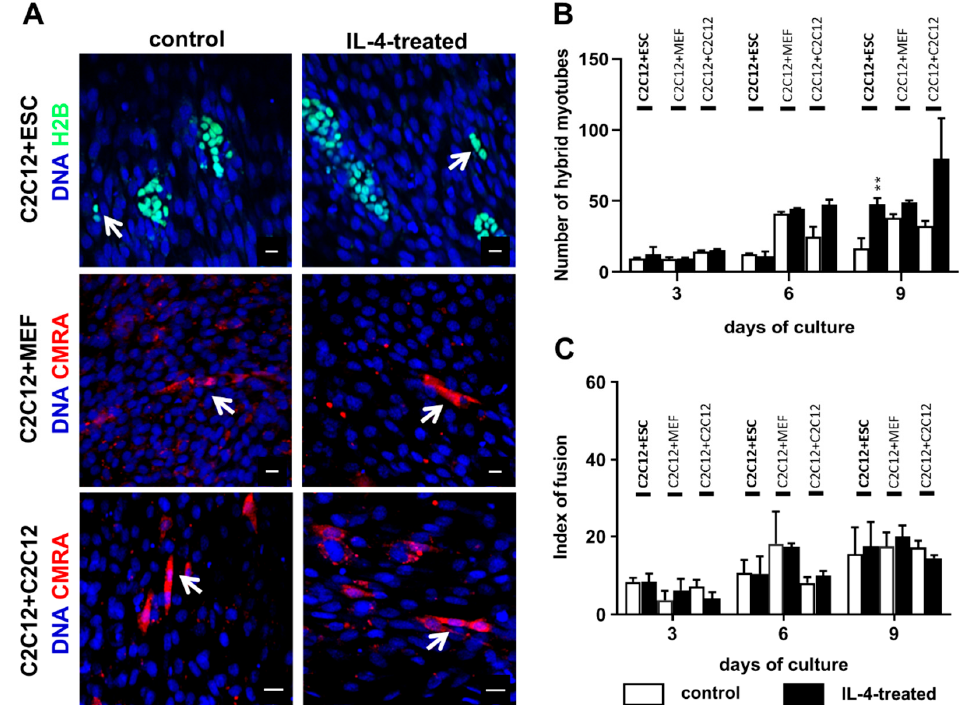
Figure 2. Analysis of IL-4 influence on fusion in the ESC-myoblast co-culture. ( A ) Representative images of hybrid myotubes in the co-cultures of di ff erentiating C2C12 myoblasts with either ESCs (C2C12 + ESC), MEFs (C2C12 + MEF) or proliferating C2C12 myoblasts (C2C12 + C2C12) conducted with (IL-4-treated) or without (control) exogenous IL-4. White arrows indicate hybrid myotubes formed in each co-culture variant. Scale bar: 20 µ m. ( B ) Number of hybrid myotubes formed in IL-4-treated and control co-cultures of C2C12 myoblasts with either ESCs, MEFs, or C2C12 myoblasts. Number of hybrid myotubes was calculated at day 3, 6, and 9 of the co-culture in three independent experiments and showed as the mean with standard deviations. ** p < 0.01 ( C ) Index of fusion in IL-4-treated and control co-cultures of C2C12 myoblasts with either ESCs, MEFs, or C2C12 myoblasts. Index of fusion was calculated at day 3, 6, and 9 of the co-culture in three independent experiments and showed as the mean with standard